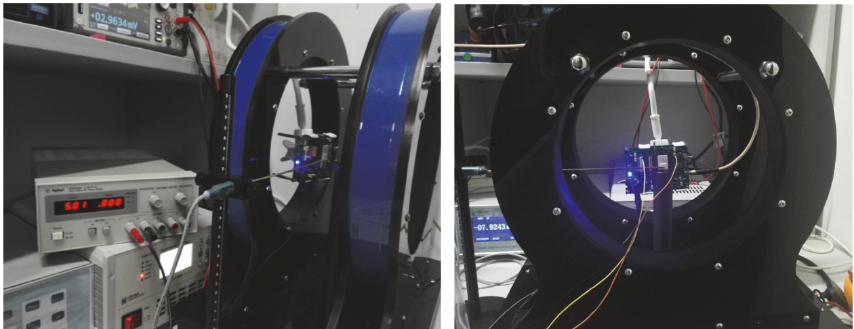
Figure 14: Physical setup of the testing system.